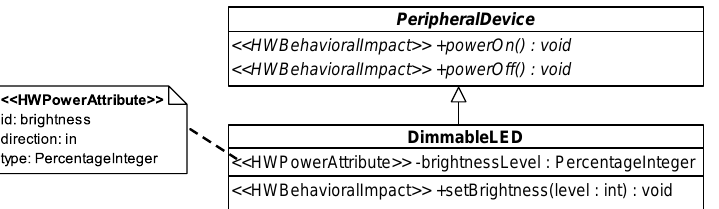
Figure 9. Class definition of the dimmable LED example (UML 2.5 class diagram notation). Unused tagged values have been omitted to improve legibility.